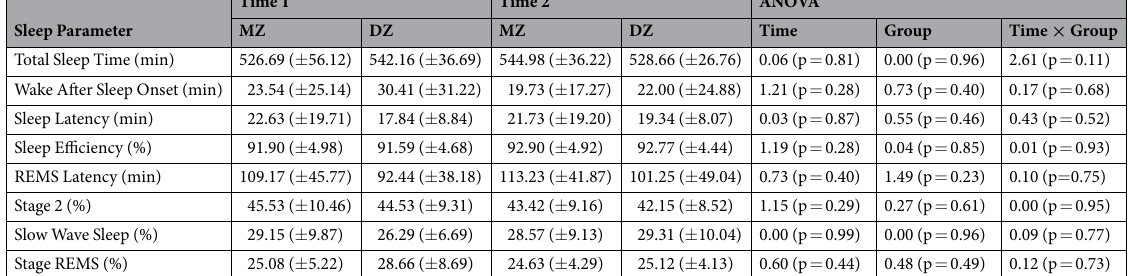
Table 1. Mean and standard deviation (in parentheses) of sleep parameters for monozygotic (MZ; n = 28) and dizygotic (DZ; n = 22) twins at two time points separated by 6 months (mean = 195 days; SD = 19 days). The percent values were calculated with respect to total sleep time. Sleep latency is defined as the first occurrence of stage 2 sleep following lights out. Results from our 2-way ANOVA with the within-subject factor Time (Time 1, Time 2) and the between-subject factor Group (MZ, DZ) and their interaction are also reported (F-values; p-values in parentheses).